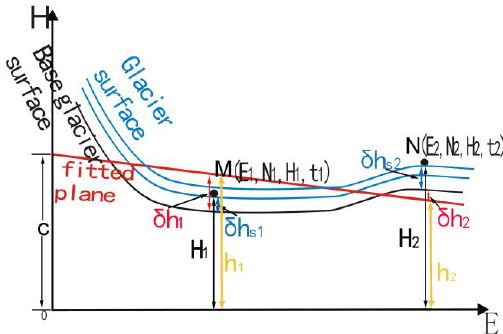
Figure 4. Sketch map of a complex terrain vertical section. The reference glacier surface is the glacier surface in an earlier year (2000 SRTM DEM in this study). 𝛿ℎ 𝑠1 and 𝛿ℎ 𝑠2 are calculated from the true glacier surface elevation, subtracting the reference glacier surface elevation at locations M and N . 𝛿ℎ 1 and 𝛿ℎ 2 are calculated from the reference glacier surface elevation by subtracting the fitted plane elevation at locations M and N , respectively. ℎ 1 and ℎ 2 are the fitted plane elevation at locations M and N . All fitted planes are parallel to the plane fitting the reference glacier surface.